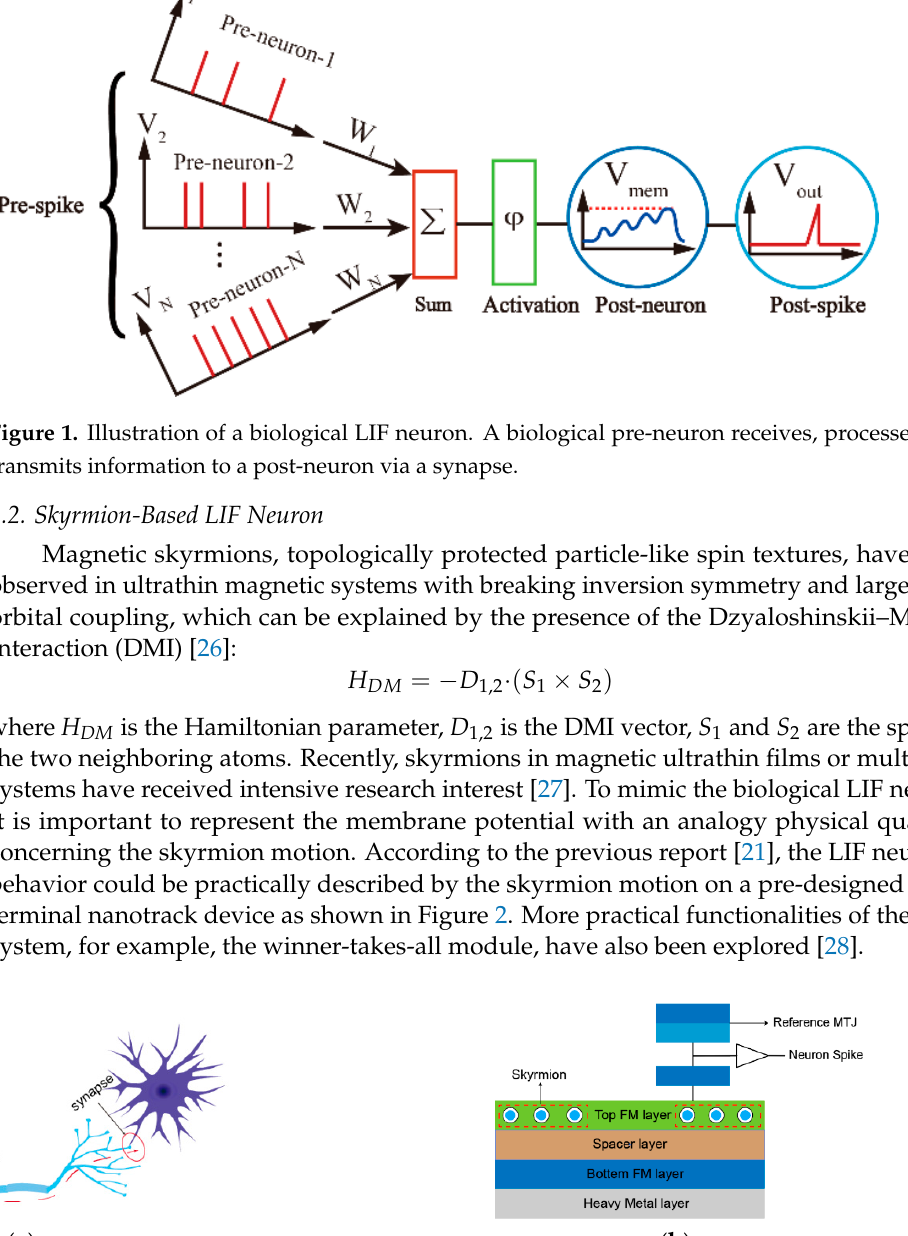
Figure 1. Illustration of a biological LIF neuron. A biological pre-neuron receives, processes, and transmits information to a post-neuron via a synapse.